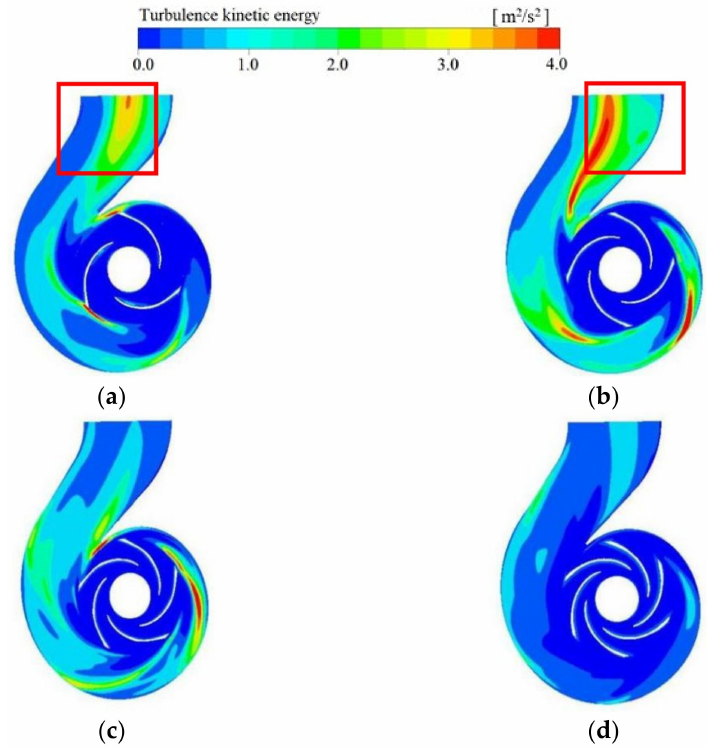
Figure 14. Turbulence kinetic energy in pump cross-section at different numbers of blades: ( a ) three- blade; ( b ) four-blade; ( c ) five-blade; ( d )